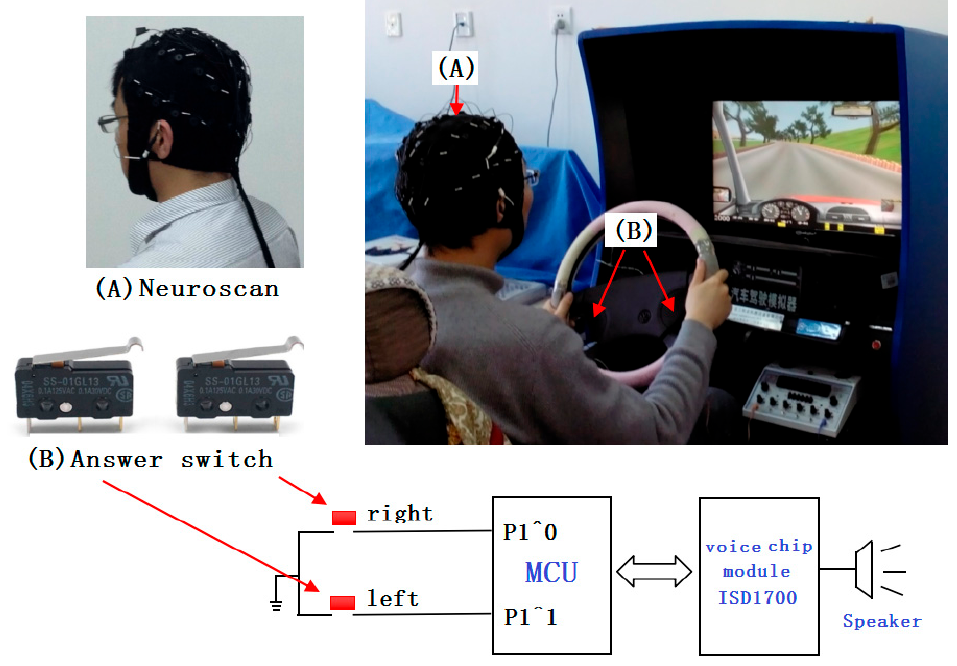
Figure 1. The experimental set-up.